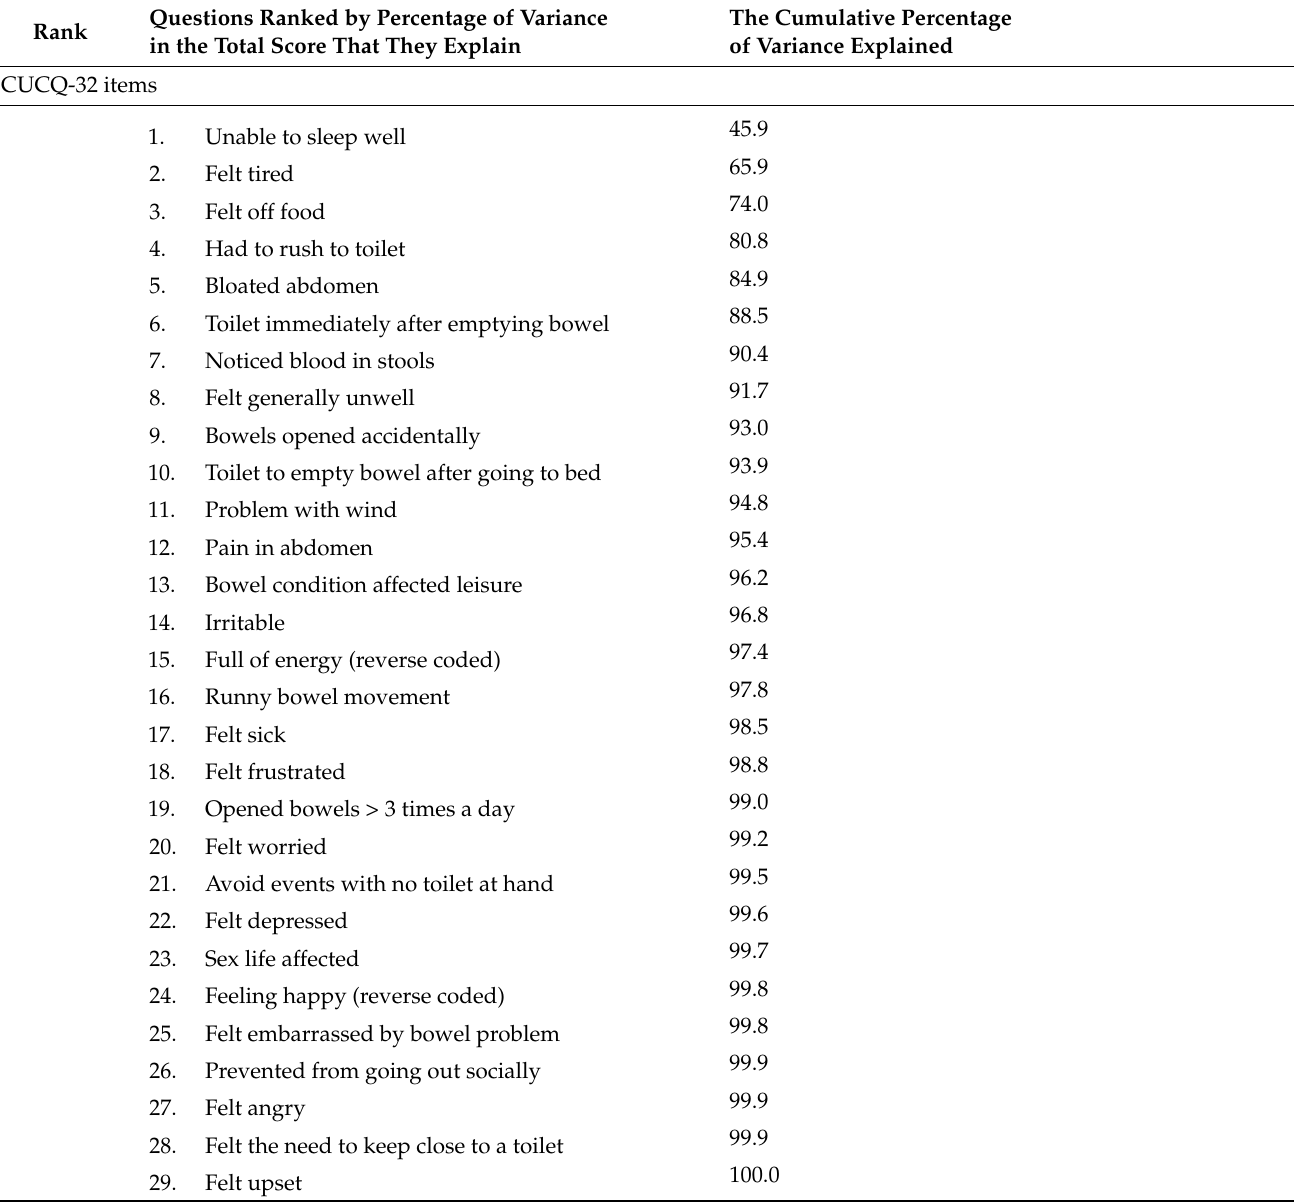
Table 1. The 32 items of the CUCQ-32 and stoma